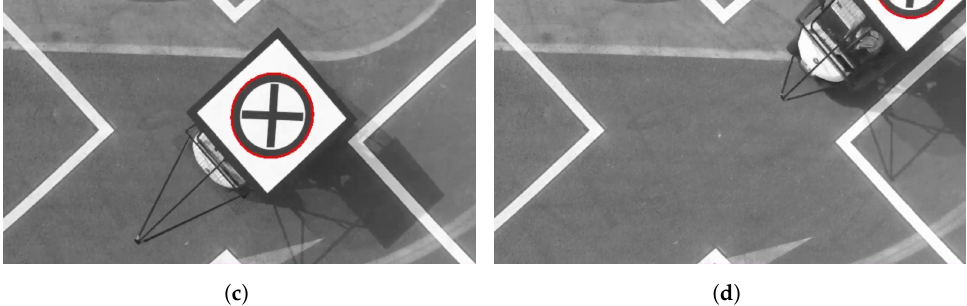
Figure 4. ( a – d ) Result of the deck detection and tracking algorithm on sample frames. The red ellipse indicates the detected pattern on the deck of the moving